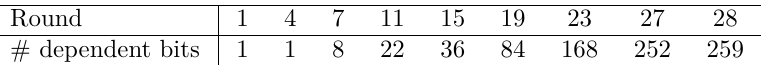
Table 3: Diffusion behavior of 0-th